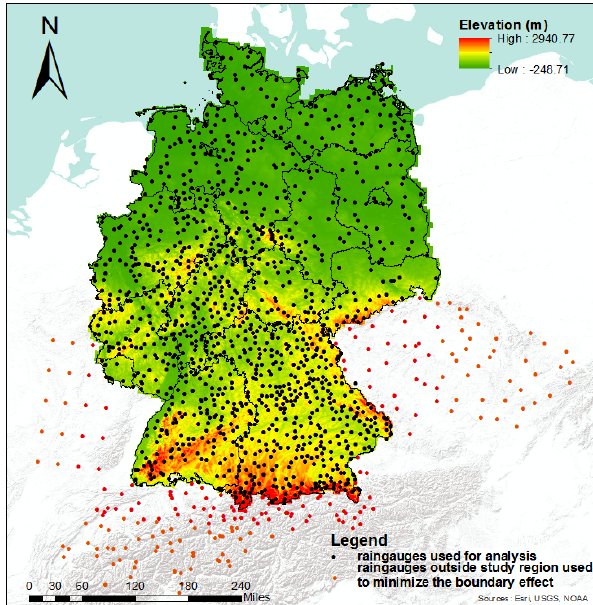
Figure 4. Location of rain stations in Germany and adjacent areas. Black dots indicate stations lying inside Germany that are used in the analysis. Red dots indicate stations outside of Germany that are used for network construction only in order to minimize the bound- ary effect. © Esri, USGS,